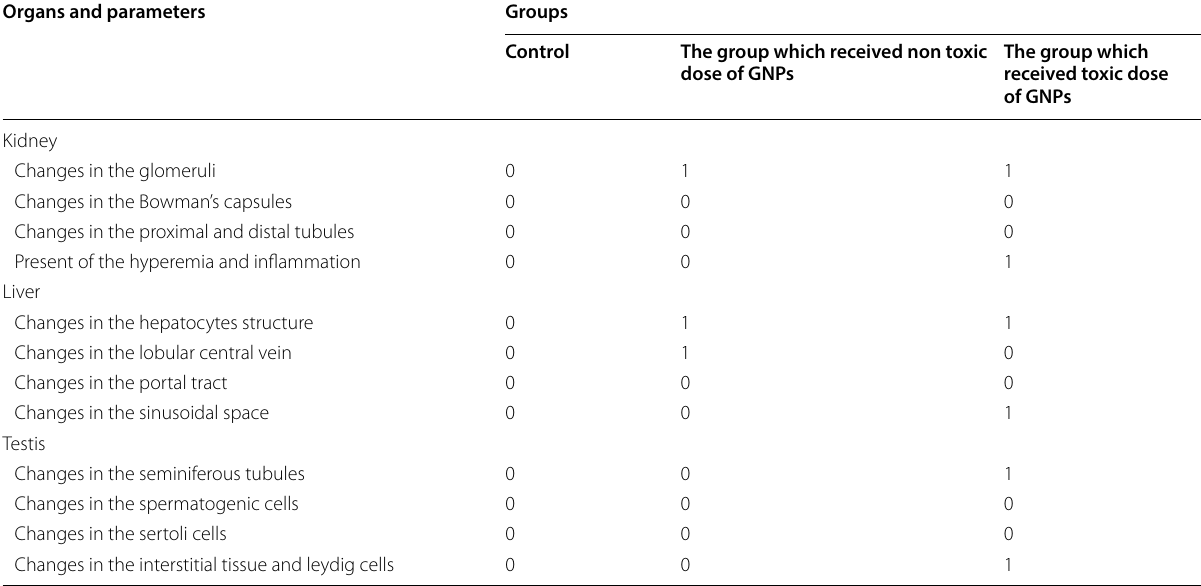
In the table, 0 represented no changes, 1 represented mild changes, 2 represented the middle and 3 represented the maximum changes